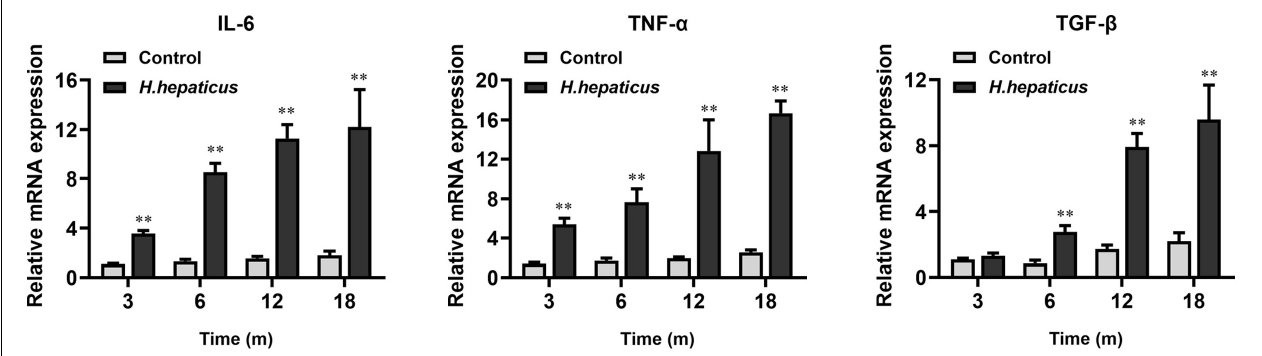
FIGURE 6 | Helicobacter hepaticus infection upregulated the levels of inflammation-associated cytokines. Relative mRNA levels of hepatic IL-6 , Tnf- α , and Tgf- β . Data are expressed as the means ± SD ( n = 5). ∗∗ p < 0.01 as compared to the control. Each group contained five mice.